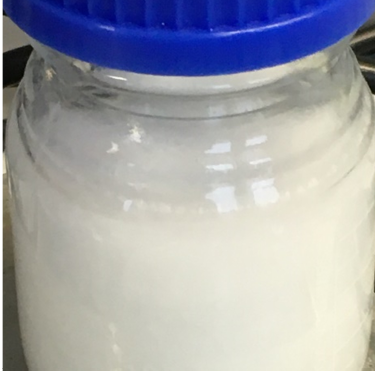
Figure A5. Image of the well-dispersed, stirred HDK-H20S suspension. There was no visible indication of non-dispersed powder.